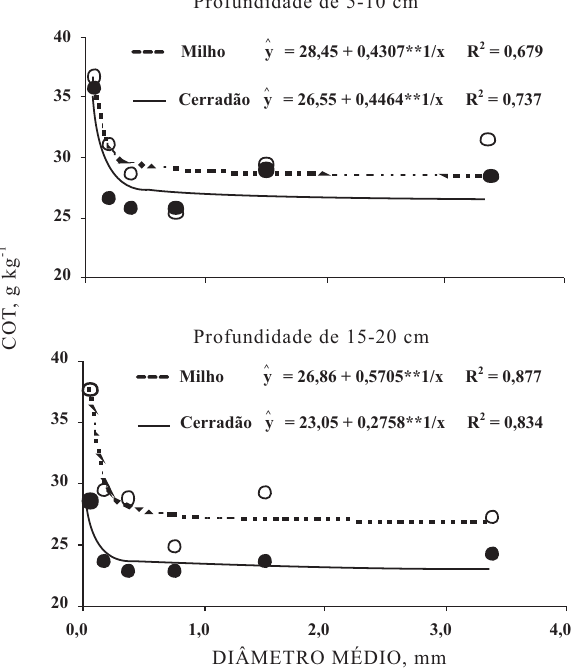
Figura 1. Carbono orgânico total (COT), em relação ao diâmetro médio dos agregados, nas profundi- dades de 5–10 e 15–20 cm de um Latossolo Ver- melho sob vegetação natural de Cerradão e sob cultivo com milho por 30 anos. **: significativo a 1 % pelo teste